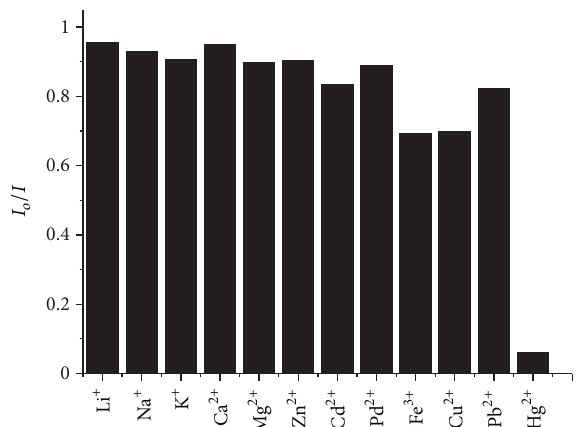
Figure 3: Effect of other metal ions on the PL of NAC-capped CdTe = 565 nm). The concentrations of Li + , Na + , K + , Ca 2+ , QDs ( 𝜆 em Mg 2+ , and Zn 2+ were 1 × 10 −3 M. The concentration of Cd 2+ was 1 × 10 −4 M. The concentrations of Pd 2+ , Fe 3+ , and Cu 2+ were 4 × 10 −6 M. The concentration of Hg 2+ was 6 × 10 −7